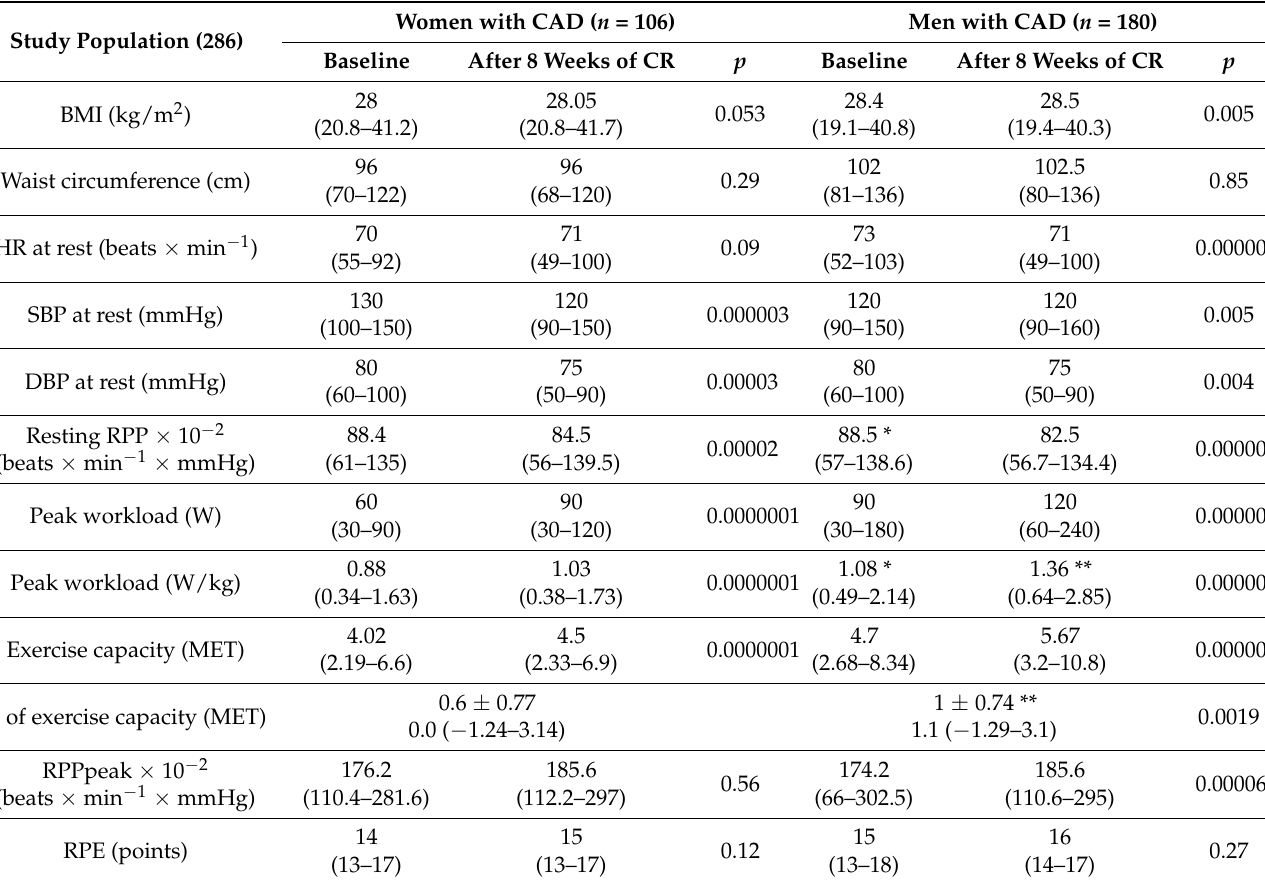
Table 4. Anthropometric and hemodynamic parameters and selected indices of exercise tolerance in the examined women and men with CAD at baseline and after 8 weeks of CR